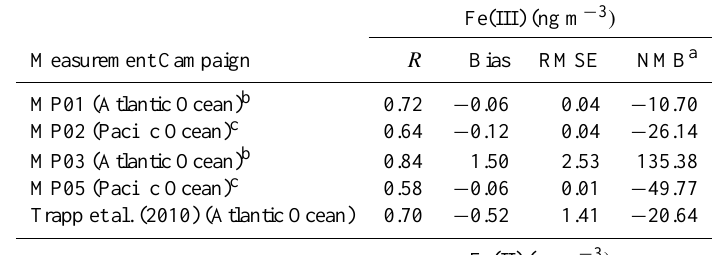
Table 5. Comparison of model-predicted Fe d values to ambient